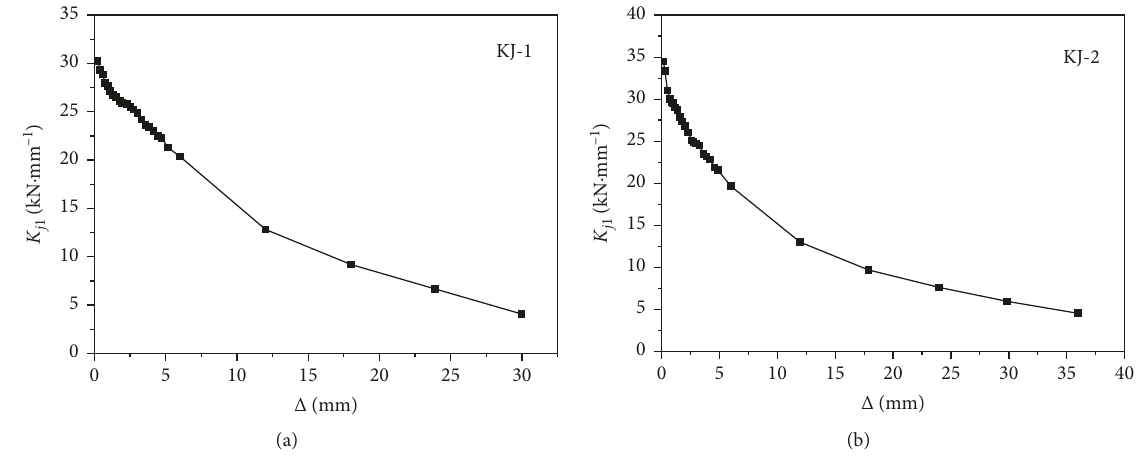
Figure 9: Stiffness degradation of specimens under each cyclic displacement: (a) specimen KJ-1, (b) specimen KJ-2.